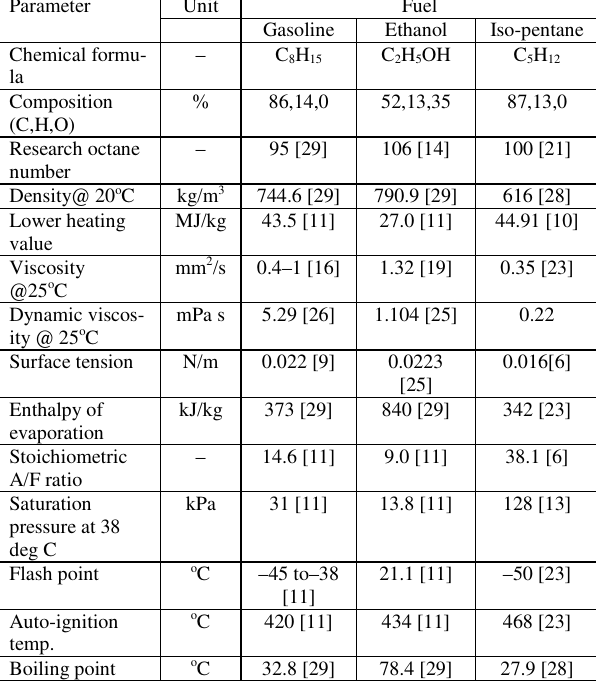
Table 4. Physical and chemical properties of fuels